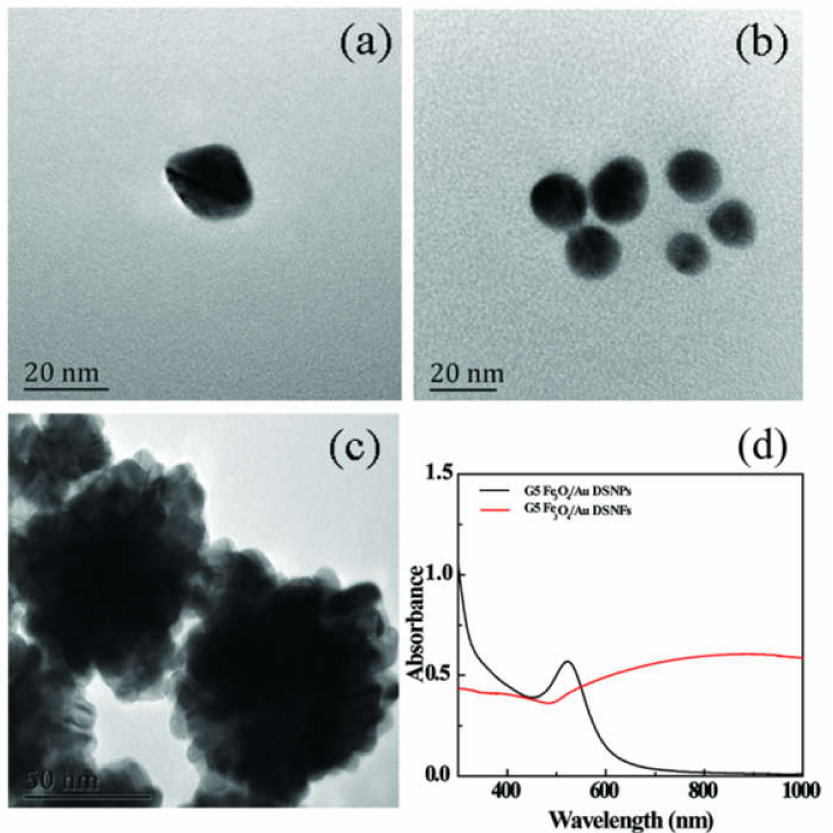
Figure 1. Structural characterization of Fe 3 O 4 /Au DSNFs. ( a ) TEM images of Au NPs, ( b ) TEM images of Fe 3 O 4 /Au DSNPs, ( c ) TEM images of Fe 3 O 4 /Au DSNFs, ( d ) UV-vis spectrum of Fe 3 O 4 /Au DSNPs and Fe 3 O 4 /Au